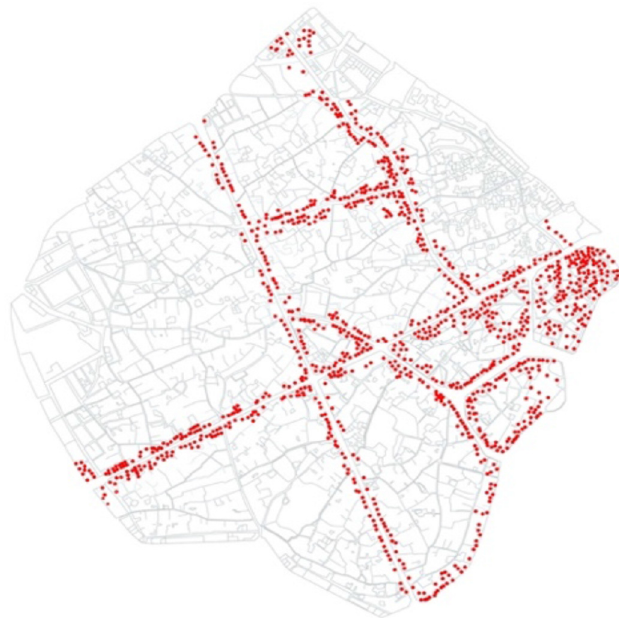
Fig. 11. Destroyed buildings on the main axes in the Old City.